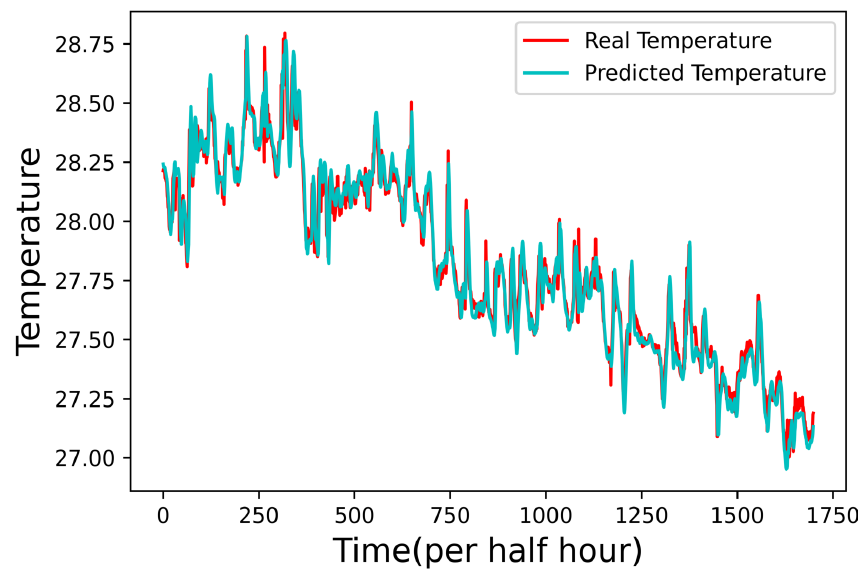
Figure 6. Prediction results of water temperature.